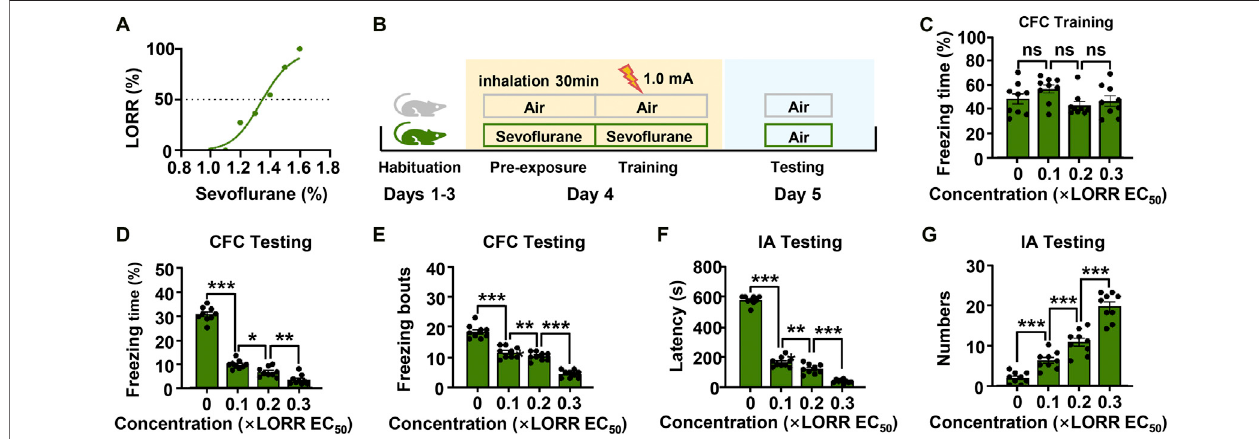
FIGURE 1 | Subanesthetic concentrations of sevo fl urane impair fear-conditioned memory in mice. (A) The dose-response curve to sevo fl urane for mice. The data were curve- fi tted using nonlinear regression. (B) Diagram of the classical fear conditioning experiment. (C) Learning evaluation of mice during the training session of the contextualfearconditioning(CFC)test. N (cid:2) 9/group. (D,E) Bargraphsshowingthepercentageoffreezingtimeandnumberoffreezingboutsformiceindifferentgroups whentheywerere-exposedtotheconditioningcontext. (F,G) Intheinhibitoryavoidance(IA) experiment, thetimetakenbeforethetrainedmice againcrossedinto the shock compartment and the times for mice to enter the shock compartment during the test period. N (cid:2) 9/group. Values are shown as the mean ± SEM; one-way analysis of variance (ANOA) with Bonferroni post hoc test. * p < 0.05, ** p < 0.01, *** p <